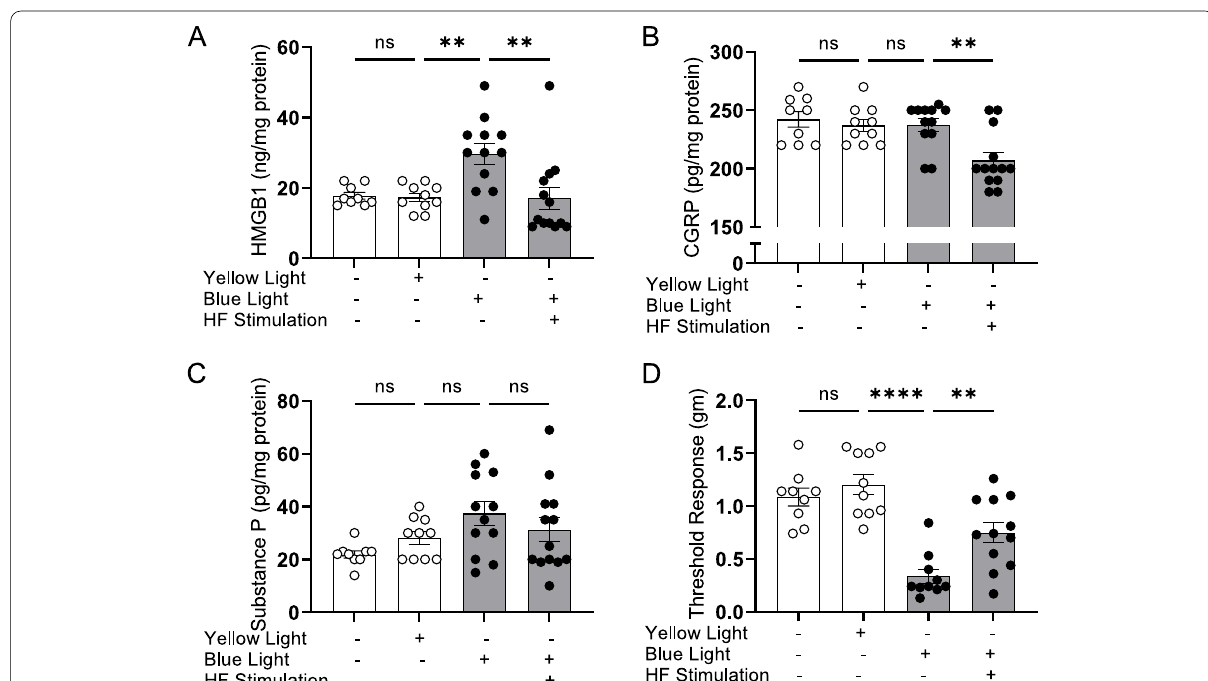
Fig. 3 HFES reduces optogenetically‑induced HMGB1 release and mechanical allodynia. Vglut2‑Cre/ChR2‑eYFP mice were anesthetized and subjected to optogenetic stimulation using 470 nm LED (blue) or 595 nm LED (yellow light) for 15 min on the dorsum of the right hind paw, followed by transcutaneous HFES of the sciatic nerve for 10 min (5 min perpendicular and parallel to the sciatic nerve, VGlut2‑ChR2‑YFP mice